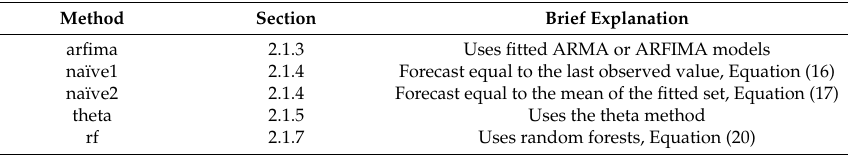
Table 1. Summary of the methods presented in Sections 2.1.3–2.1.7 and their abbreviation as used in Section 3.